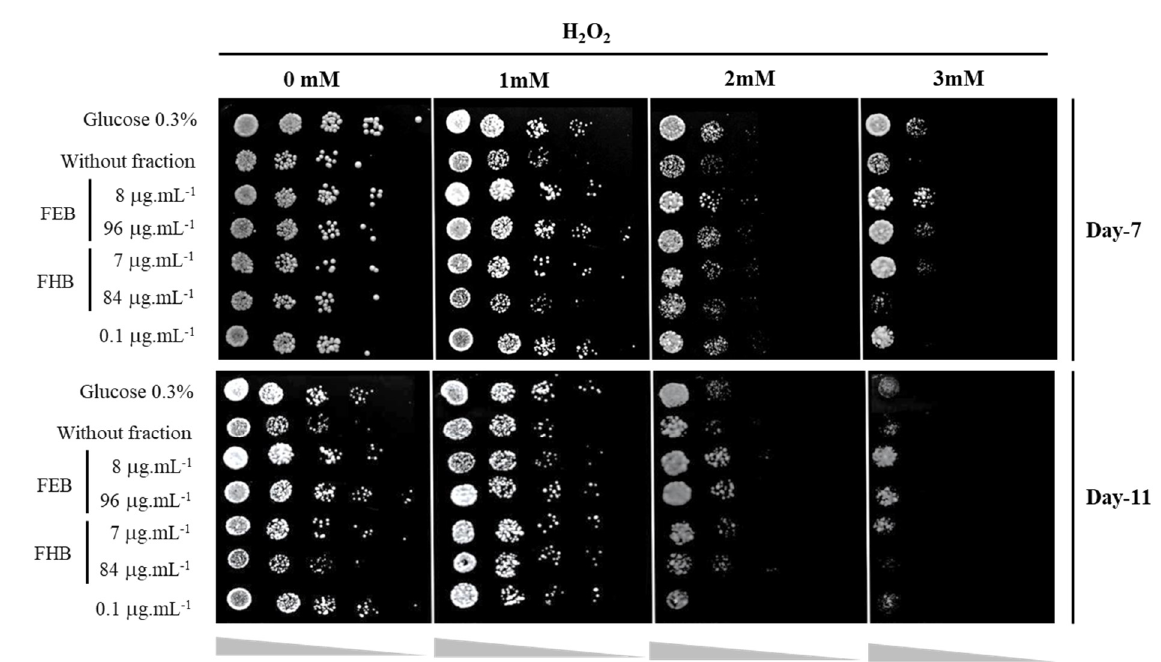
Figure 3. The effect of the treatment of two selected concentrations of each clove bud fraction on the viability of S. pombe against H 2 O 2 –induced oxidative stress conditions after 7 and 11 days of incubation. FHB: clove bud n-hexane fraction, FEB: clove bud ethanol fraction. Yeast grown in low glucose (0.3%) was designed as positive longevity control, while yeast grown in normal YES medium withour fraction was used as a negative control. Ascorbic acid was used as a control of antioxidant treatment.